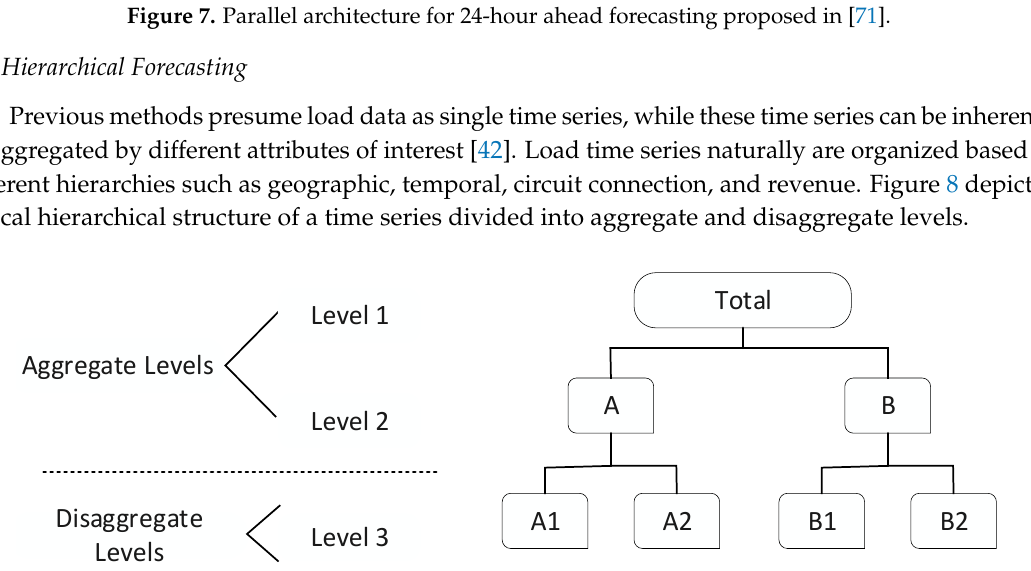
Figure 8. Schematic diagram of hierarchical structure of a load time series.